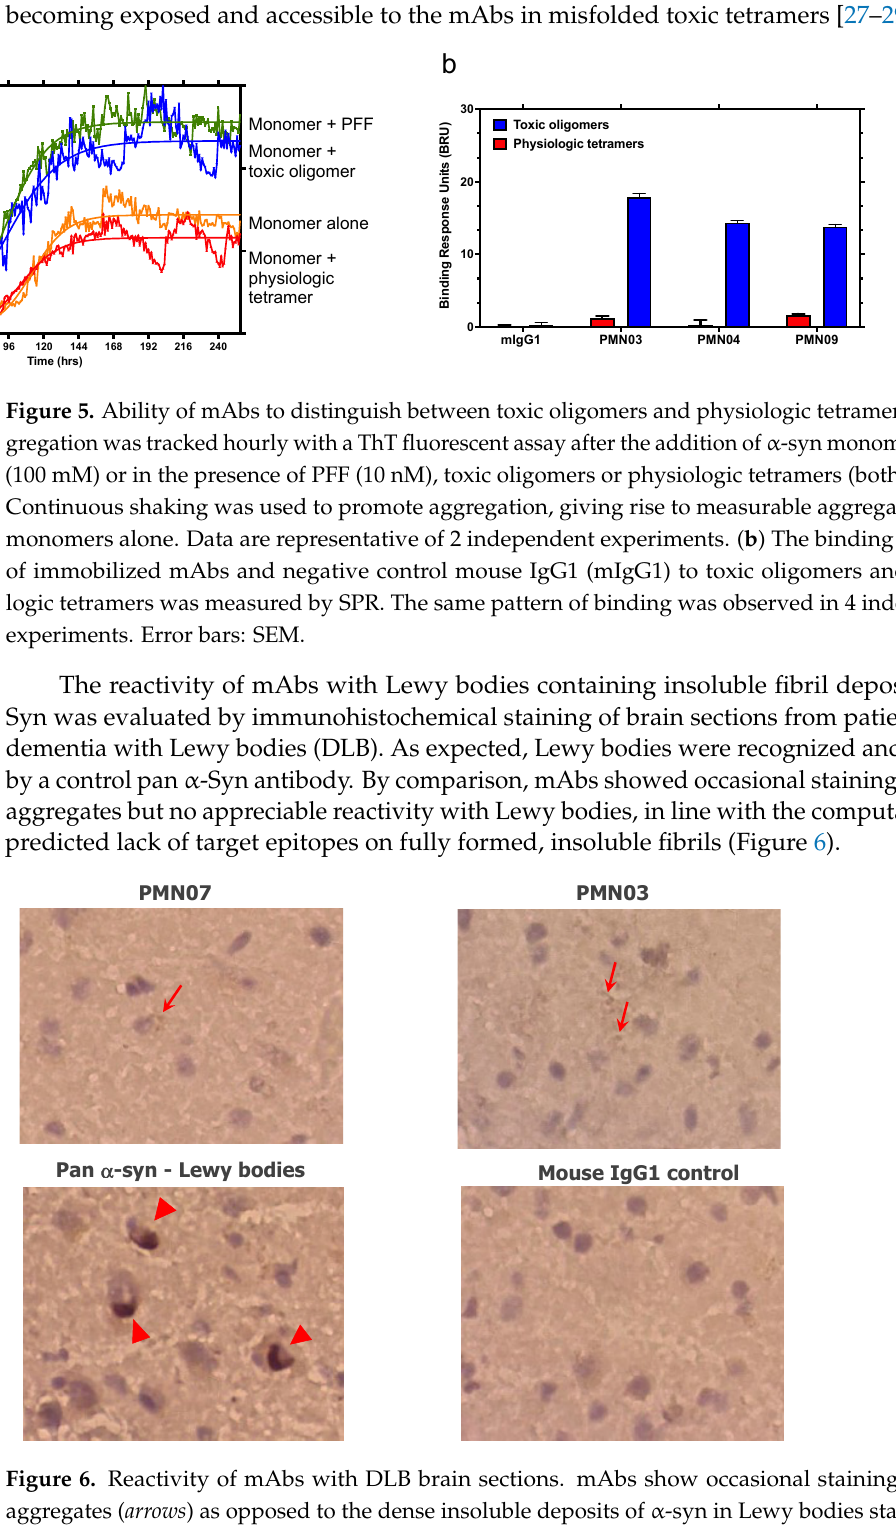
Finally, the reactivity of mAbs with native pathogenic α -Syn species in patient brain extract was assessed by SPR analysis. As shown in Figure 7, immobilized mAbs showed robust binding to α -Syn in soluble brain extract from patients diagnosed with DLB (Figure 7a) or MSA (Figure 7b). With MSA brain extract, the magnitude of binding by all mAbs was equivalent to or greater than that of a control pan α -Syn antibody capable of binding both normal and pathogenic α -Syn species.